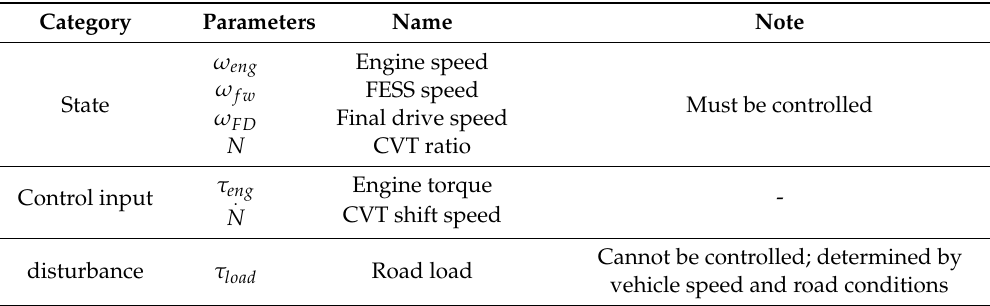
Table 1. State information of the